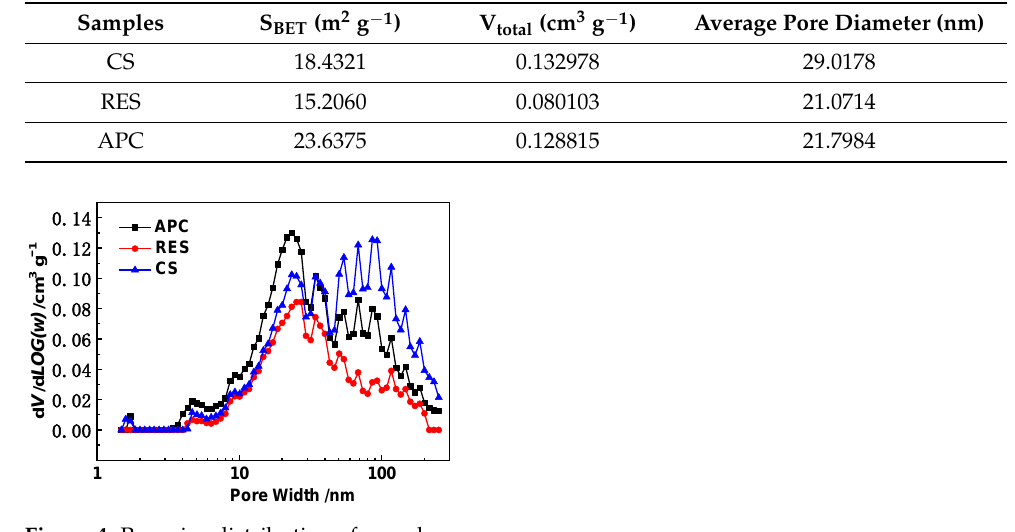
Figure 4. Pore size distribution of samples. Table 3. Surface and pore structure statistics of samples measured from N 2 absorption.